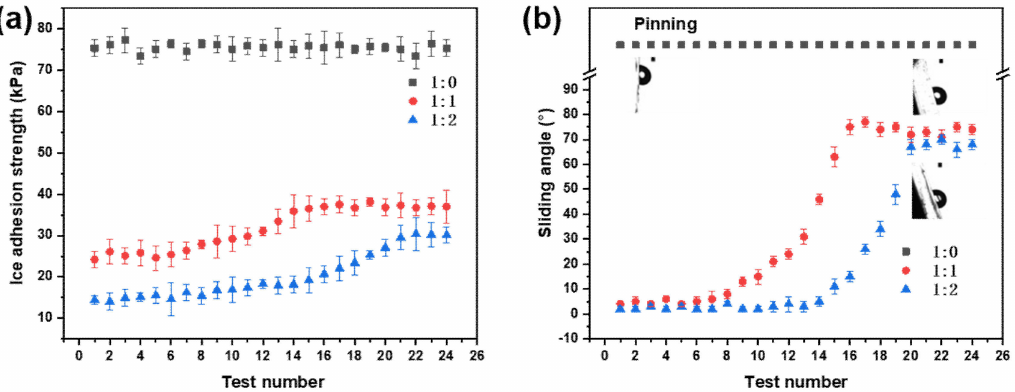
Figure 10. The variation of ( a ) ice adhesion strength and ( b ) sliding angle of di ff erent sample surfaces during the icing / deicing cycle